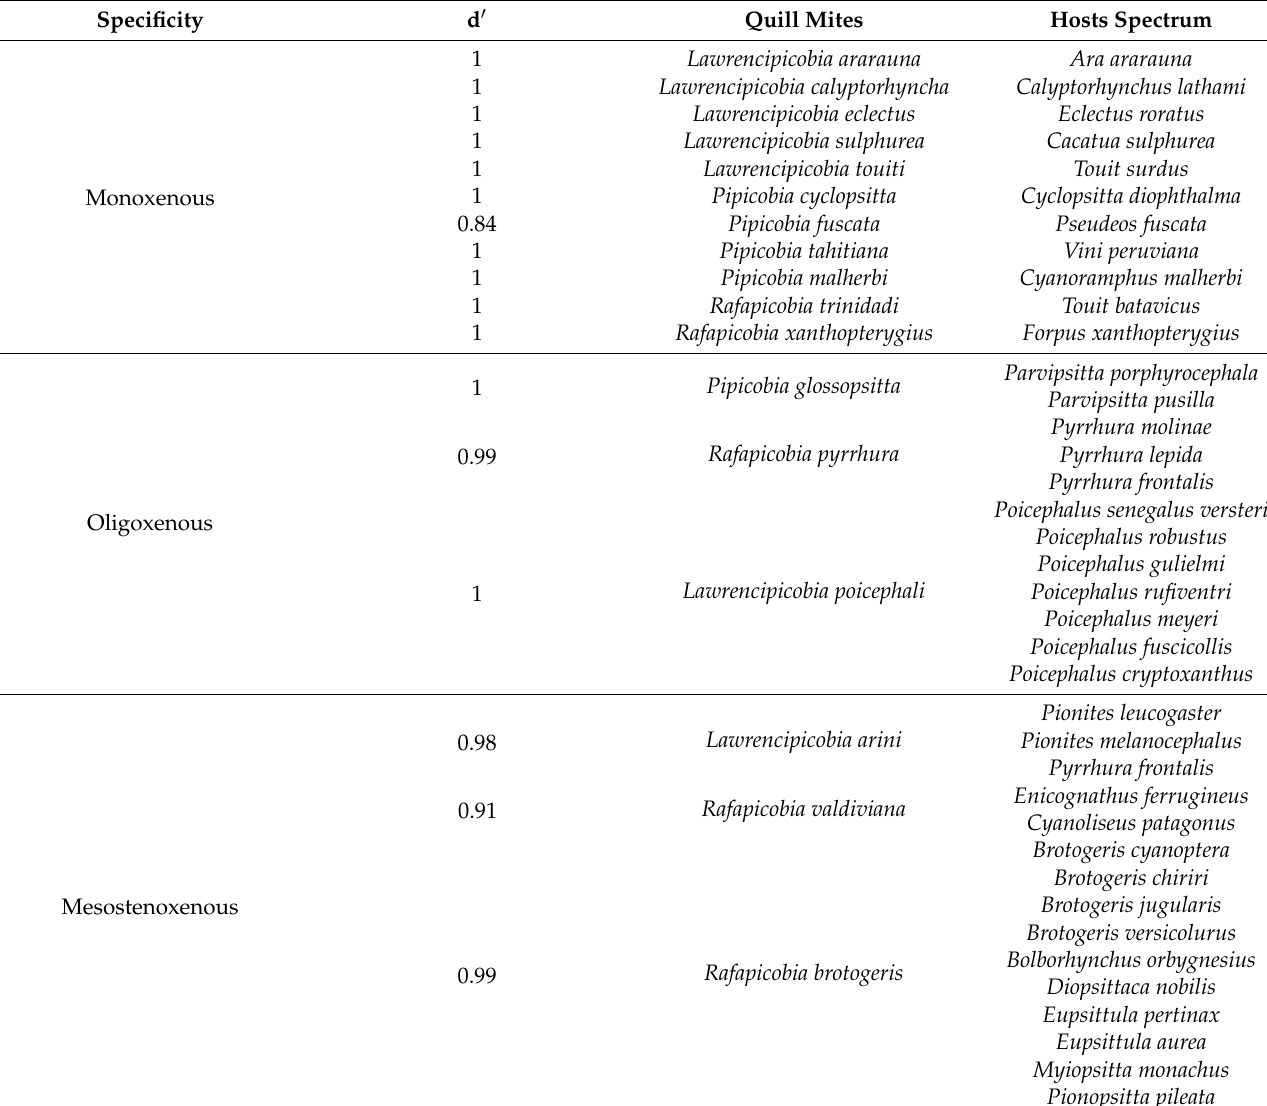
Table 4. Host specificity of quill mite species the subfamily Picobiinae with the value of d (cid:48)